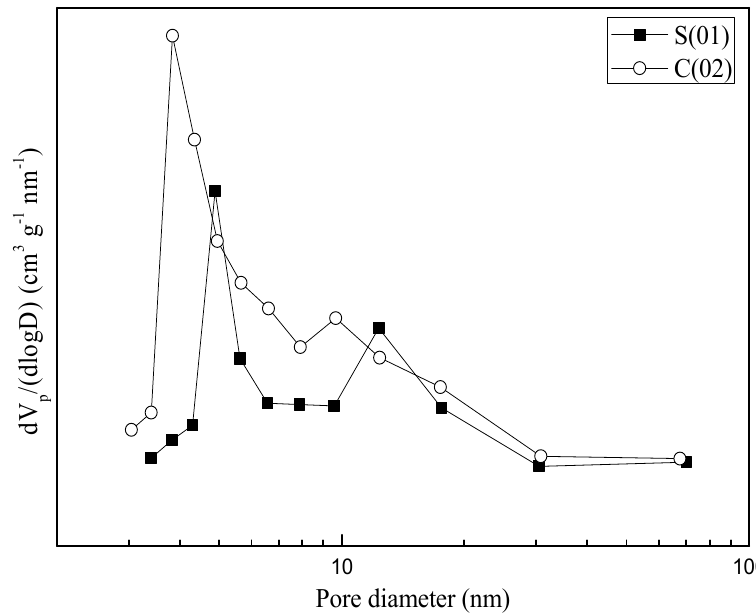
Figure 8. Pore size distributions of MnO 2 obtained in S-CFMCR and C-CFMCR, respectively.